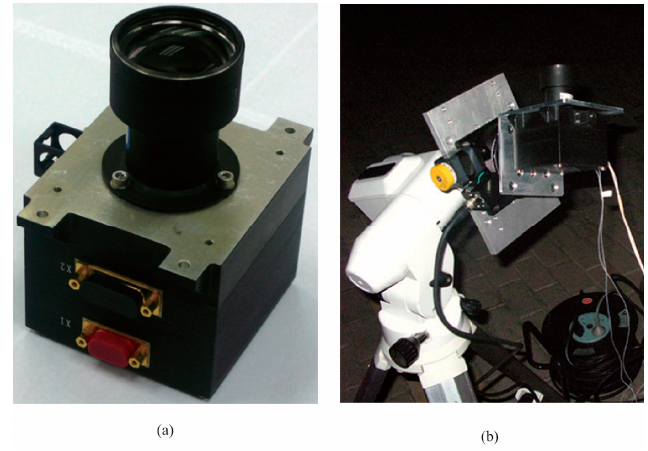
Figure 13. Star sensor used for the night sky experiments. ( a ) Our own star sensor. ( b ) Night sky experiments.